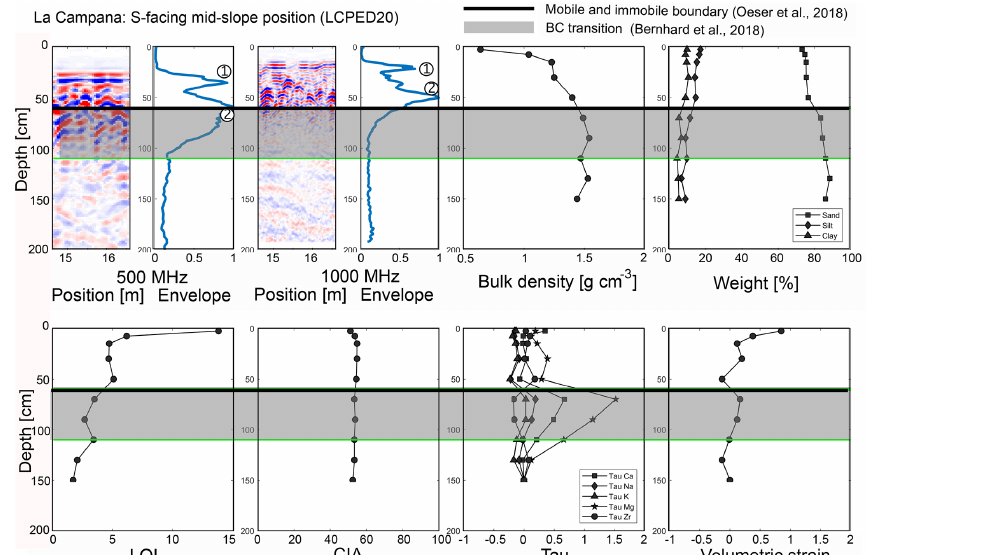
Figure 8. Compilation of physical and chemical investigations at the pedon location in the mid-slope position of the S-facing hillslope in La Campana. Properties shown are listed in caption of Fig. 4.